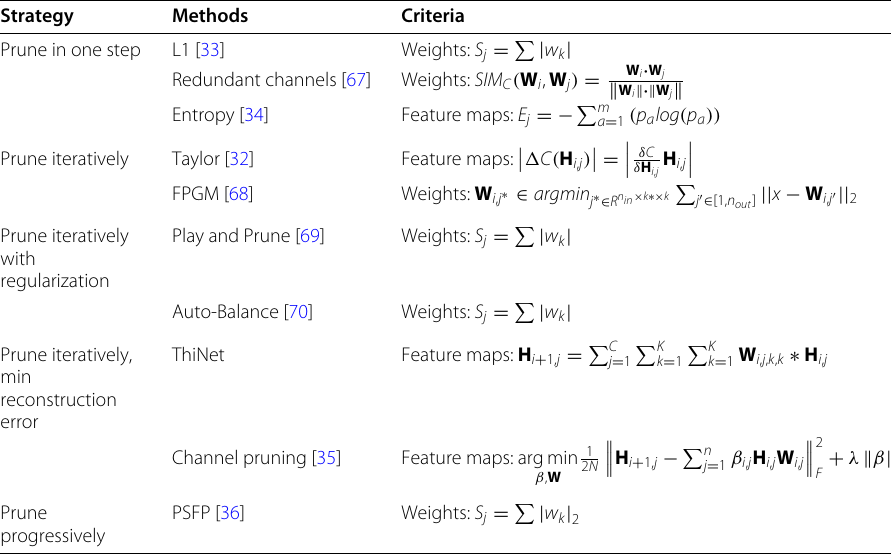
Table 2 Main properties of different channel pruning